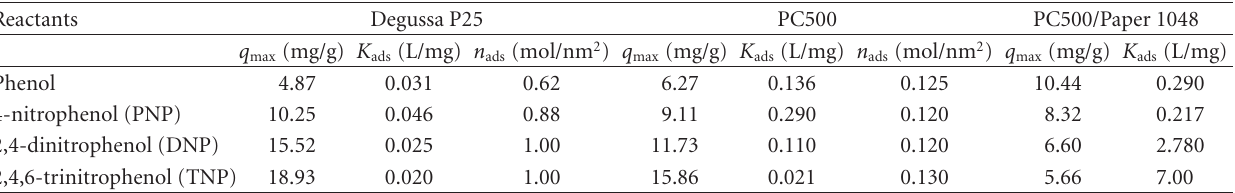
Table 2: Langmuir parameters of phenolic compound adsorption.